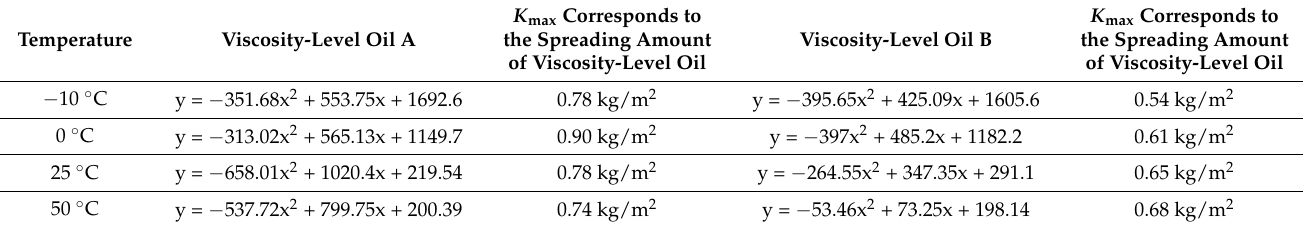
Table 9. The best range of adhesive oil spread.